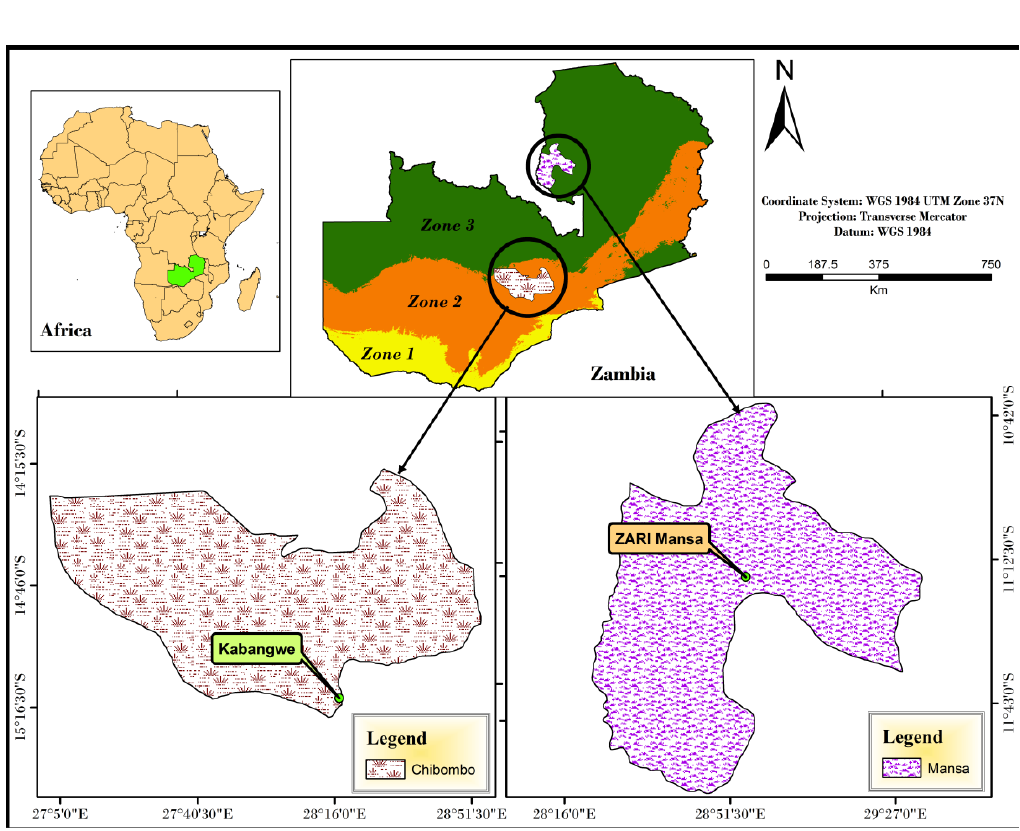
Figure 1. Map of the study sites and their respective districts on a map of the Republic of Zambia.